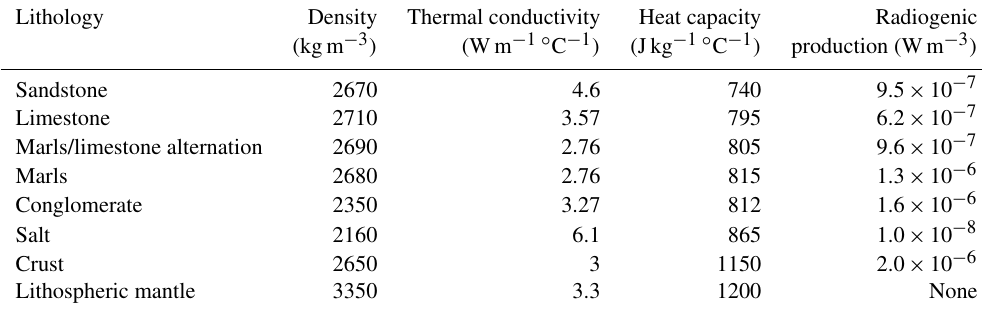
Table 1. Rock properties adopted for modelling with